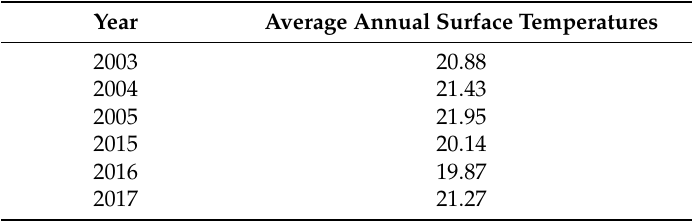
Table 1. Reservoir’s average annual surface temperatures ( ◦